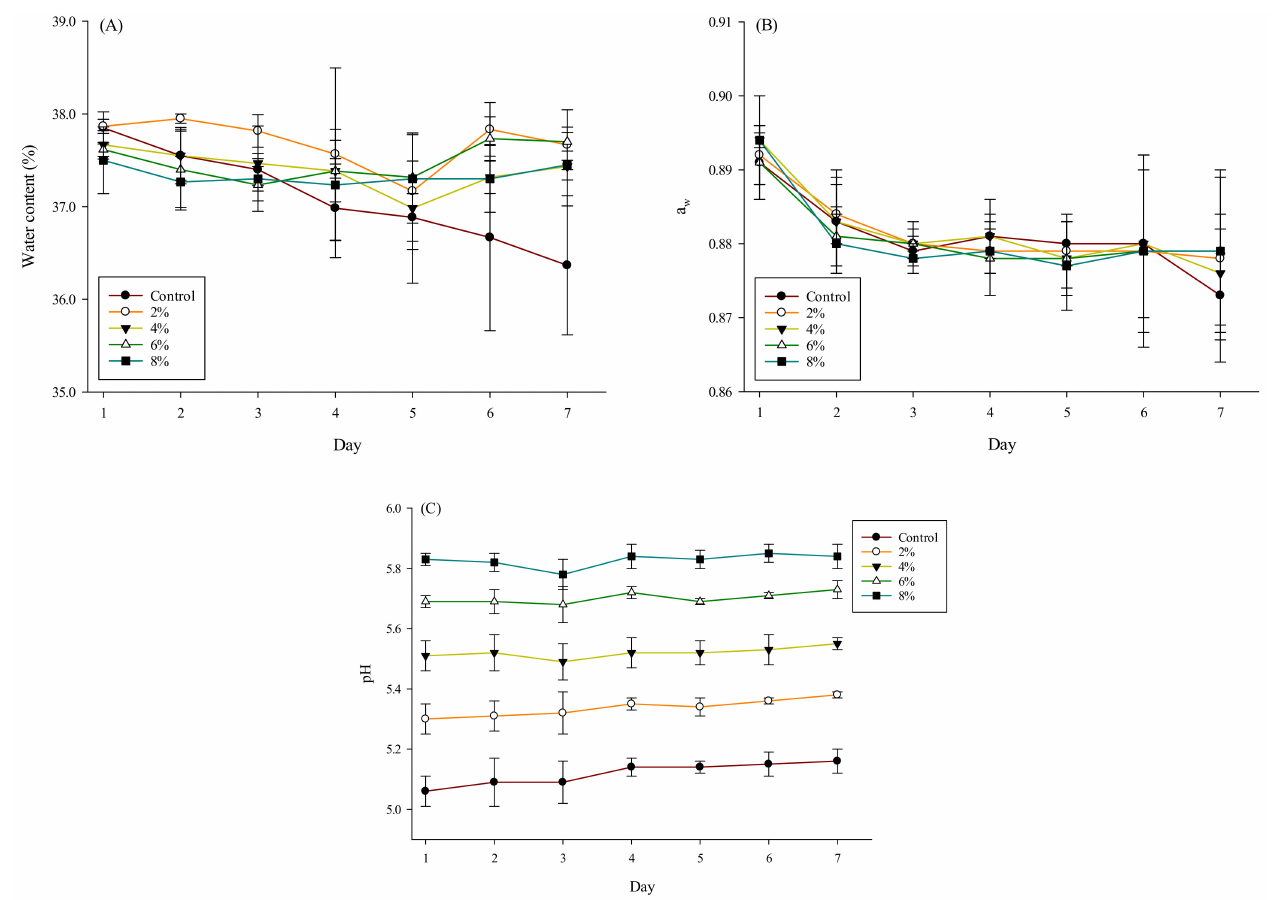
Figure 2. Effects of partially substituting high-gluten flour with soy protein isolate on the ( A ) moisture content, ( B ) a w , and ( C ) pH of